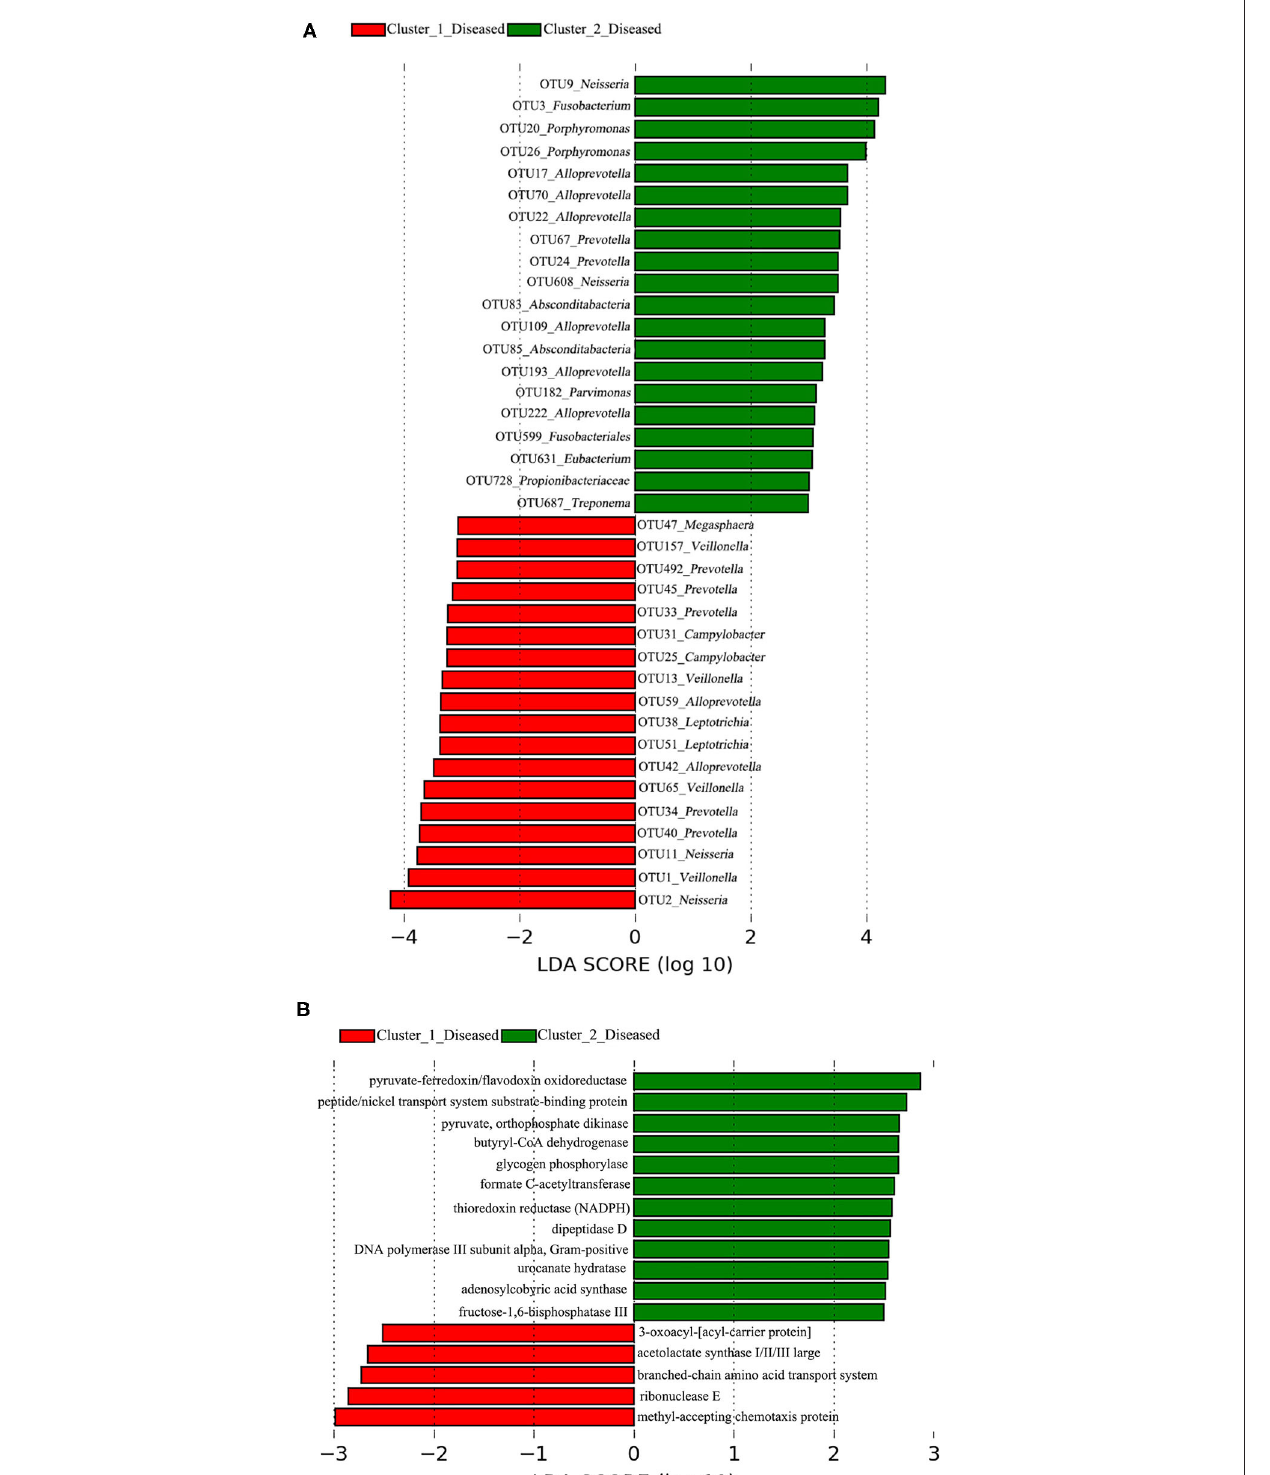
Frontiers in Medicine |